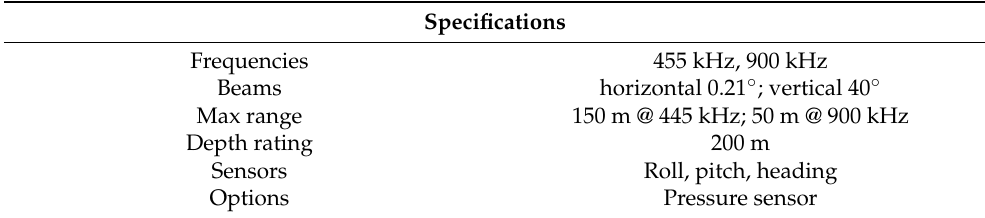
Table 3. Technical specifications of the side-scan sonar Klein